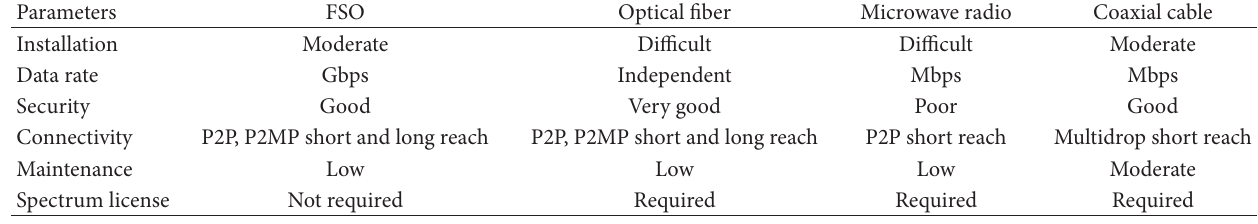
Table 1: Comparison of FSO with different communication system.